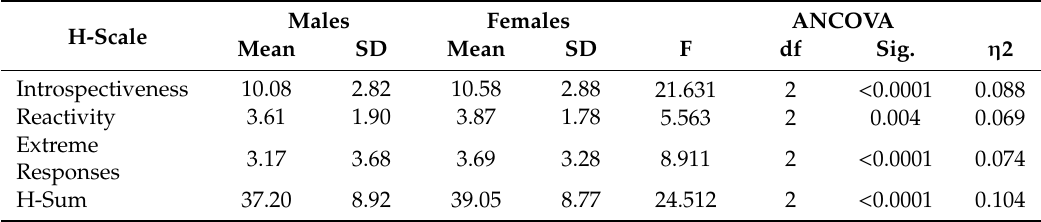
Table 5. Gender di ff erences in